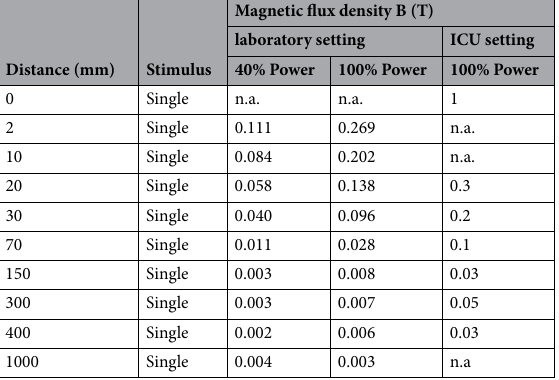
Table 1. Comparison of magnetic flux density in a laboratory and ICU setting at different distances to the stimulation coil. B (T) magnetic flux density in Tesla.